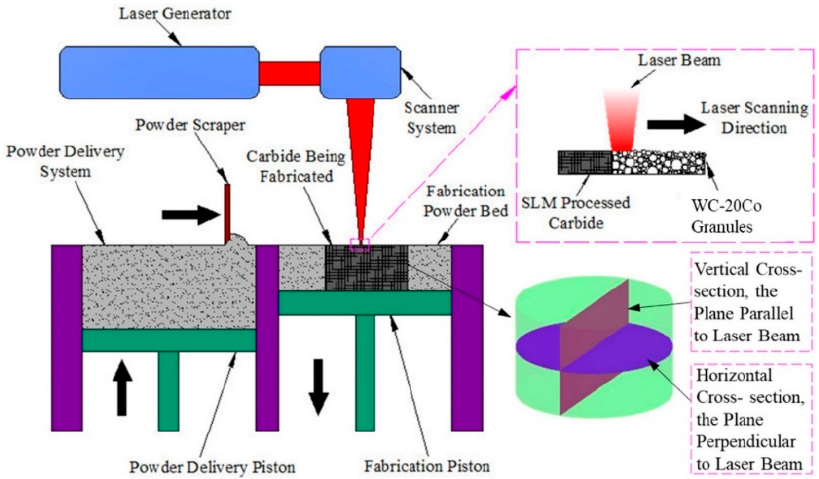
Figure 19. Schematic design of the SLM approach. On both the vertical (parallel to the laser beam) and horizontal (perpendicular to the laser beam) cross-sections of the SLM-treated carbides, microstruc- tural analysis and hardness tests were performed (adapted with permission from reference